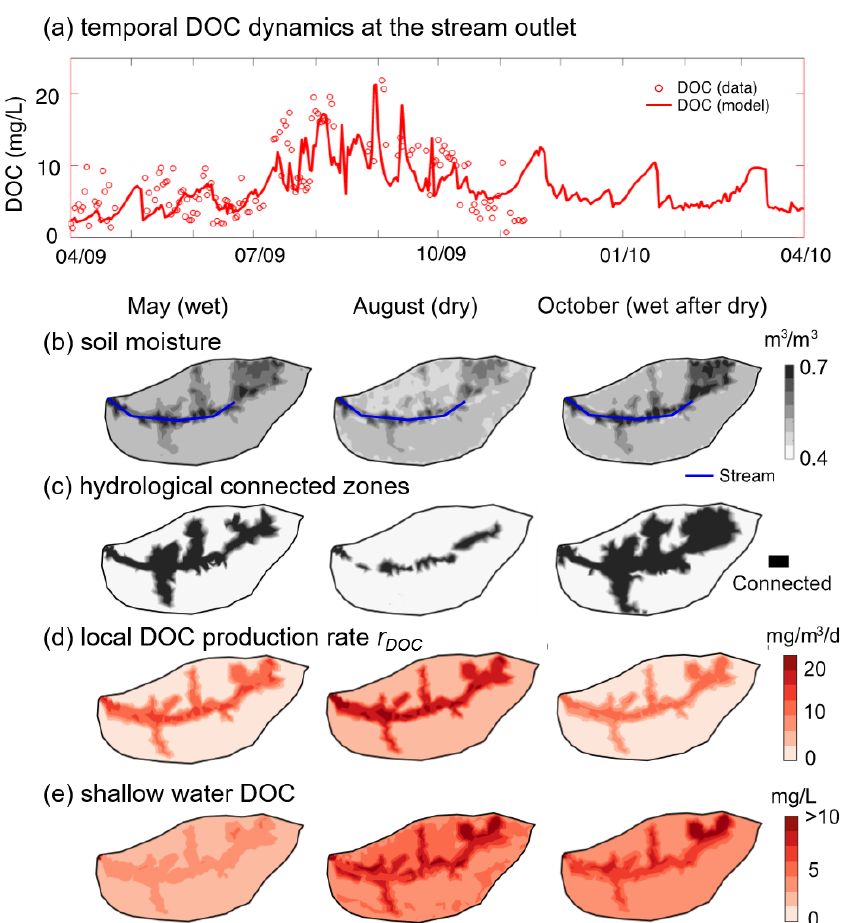
Figure 10. (a) Temporal dynamics of stream DOC concentration; spatial profiles of (b) shallow soil moisture, (c) hydrologically connected zones, (d) local DOC production rates r DOC , and (e) shallow-water DOC concentration in May (wet), August (dry), and October (wet after dry) of 2009. The soil DOC and r DOC were high in swales and valley with relatively high shallow-water and SOC content. August had the highest shallow-water DOC concentration compared to May and October because most DOC accumulated in zones that are disconnected to the